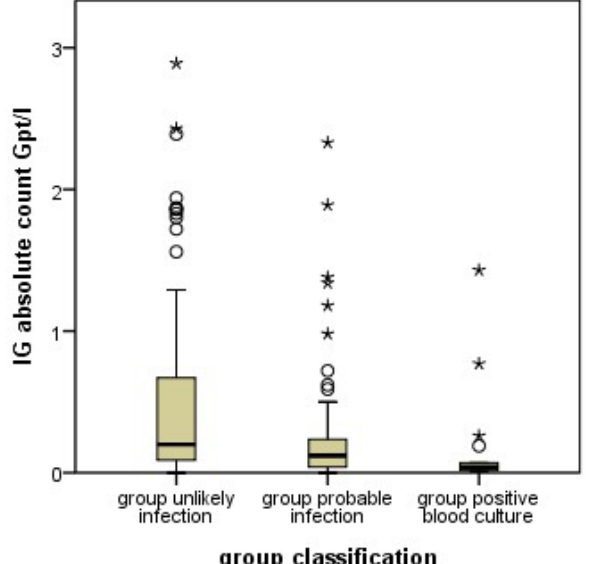
Figure 1. Boxplot of the numbers of immature granulocytes (IG) as counted by the Sysmex XN-9000 ® flow cytometers in the unlikely infection (UI), probable infection (PI) groups as well as the positive blood culture (PC) subgroup. The PI group had lower counts of immature granulocytes than the UI group ( p < 0.001). This effect was even stronger in the PC subgroup with positive blood culture. The boxes show median, and interquartile range, the whiskers 95% confidence range, ○ = outliers, ★ = extreme outliers.